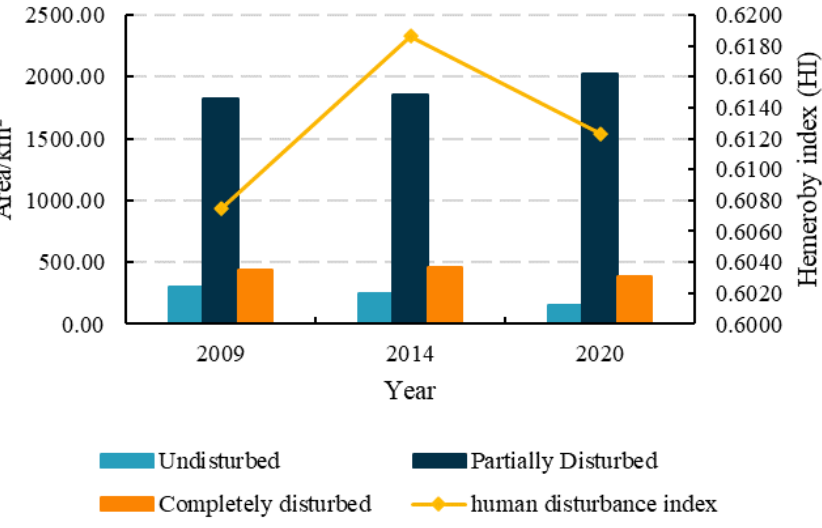
Figure 7. The human disturbance index of the study area from 2009 to 2020.